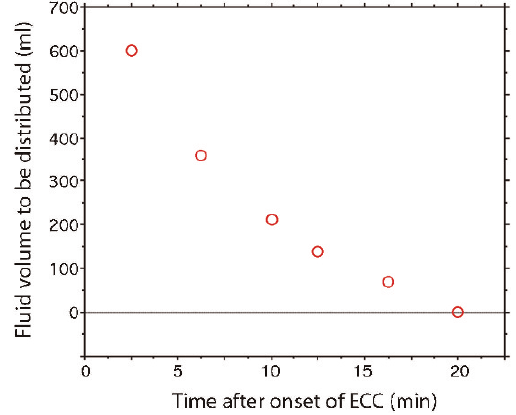
Figure 1 - Blood volume over time and when sampling was conducted.